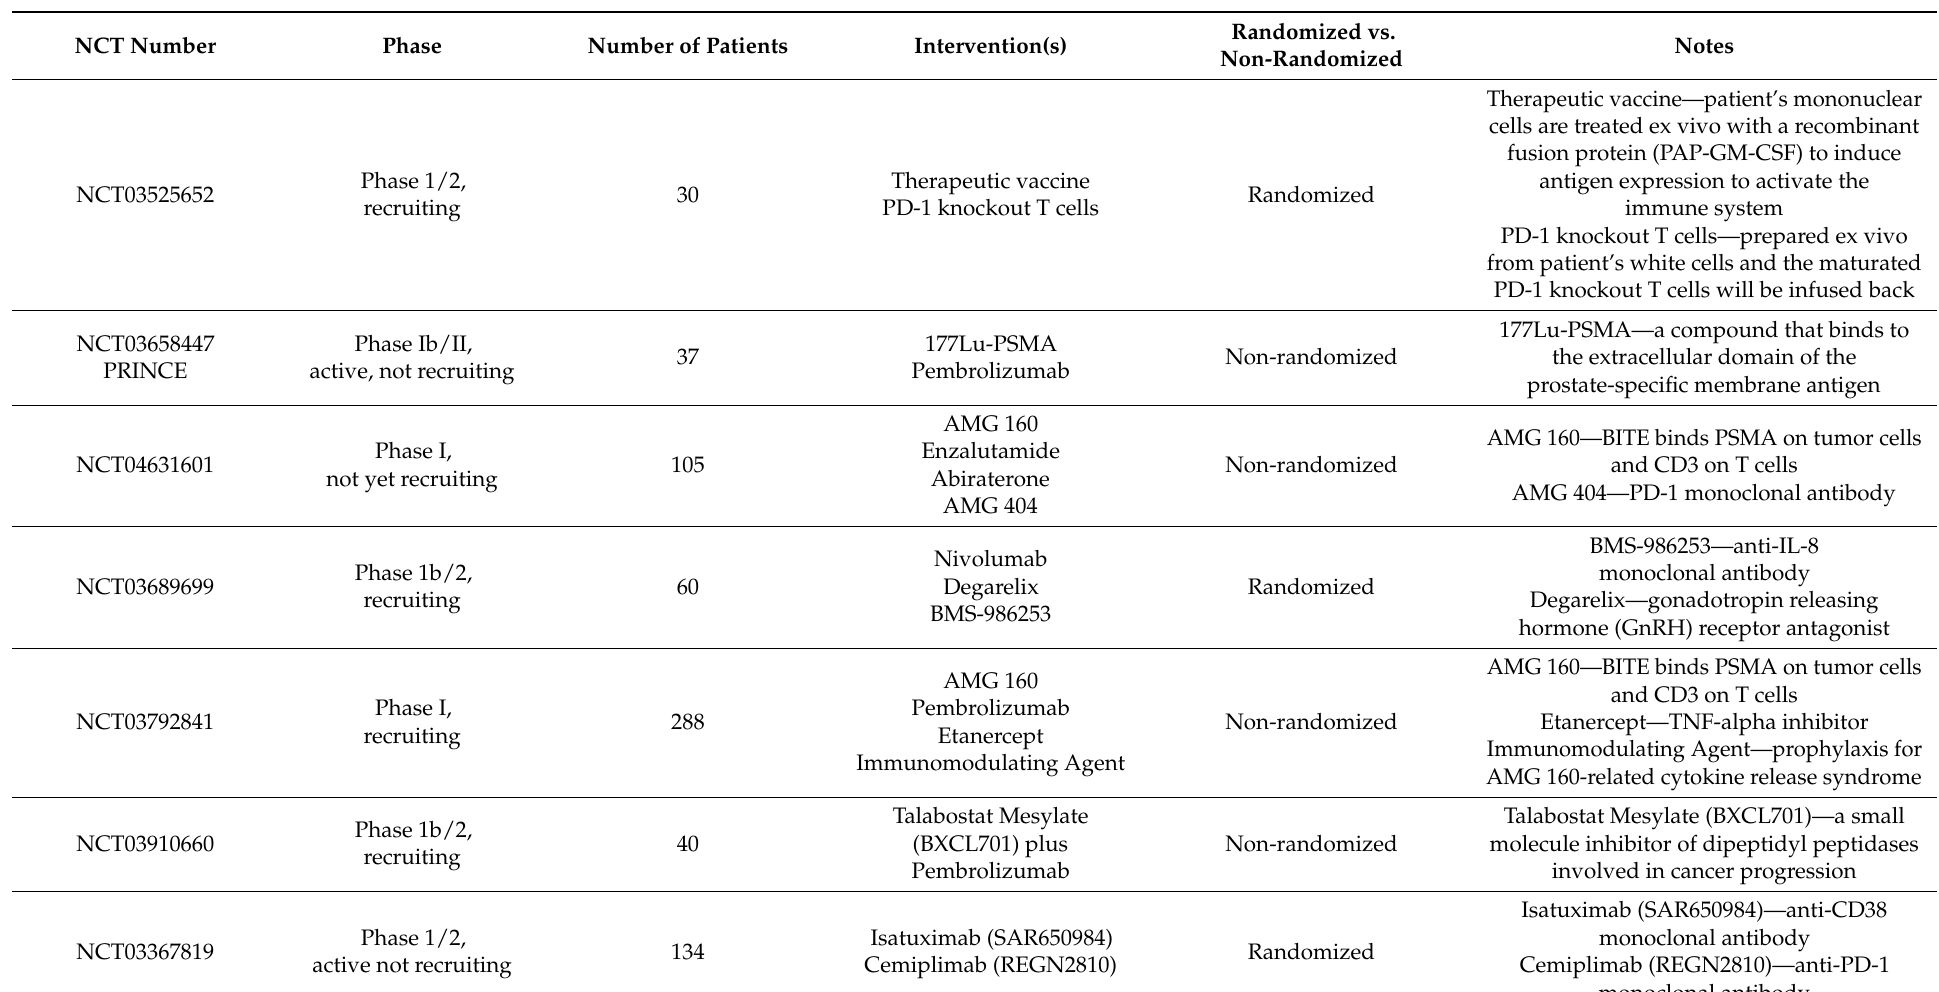
Table 3. Selected ClinicalTrials.gov trials involving immune checkpoint blockade in prostate